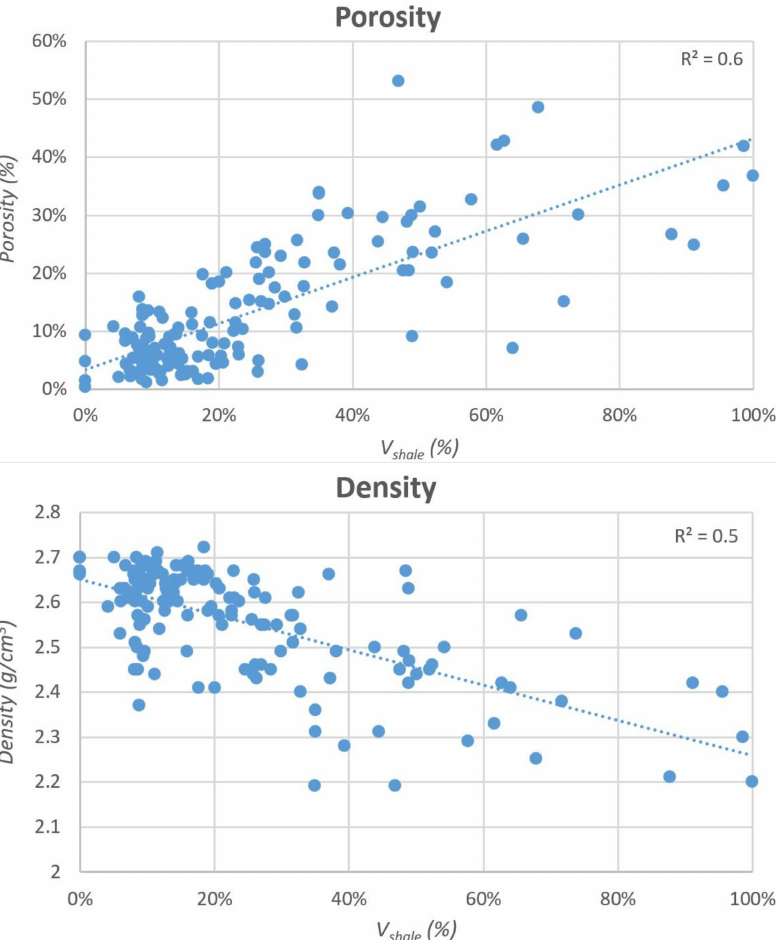
Figure 14. Correlation between the V shale and Porosity-Density values. The R 2 values are rounded to the first decimal